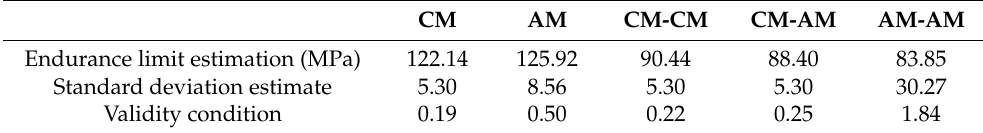
Table 10. Estimation of endurance limits.